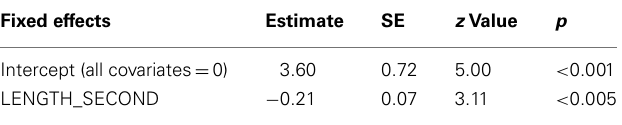
Table 6 | Fixed effects of model fit only on IB.